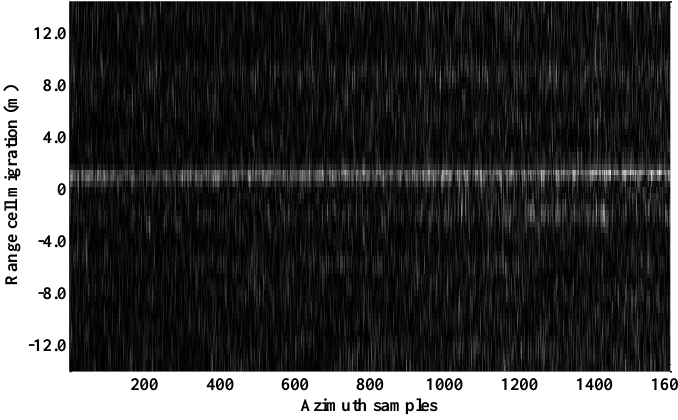
Figure 14. Range profiles with the proposed NsRCM correction.